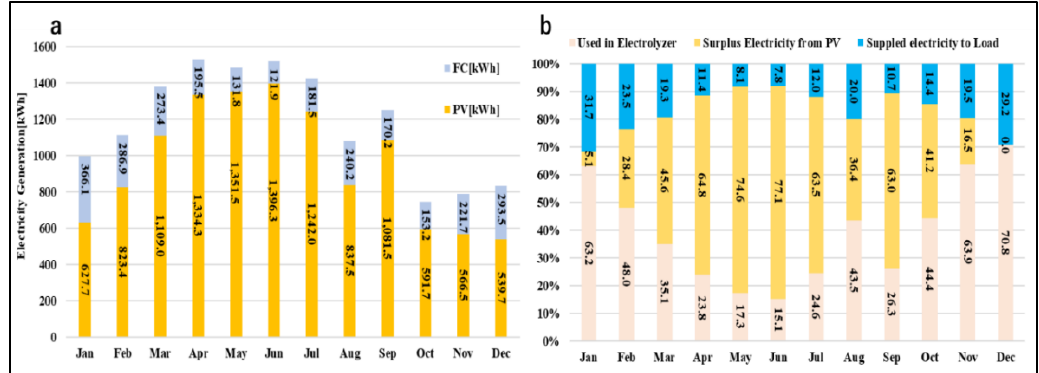
Figure 14. Monthly average electricity supply and demand in scenario 2: ( a ) total electricity generation from the HRES; ( b ) usage of the total electricity.